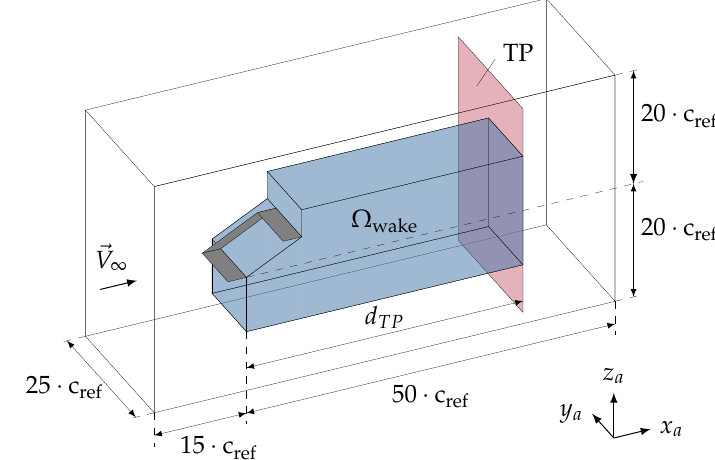
Figure 2. Schematic illustration of the flowfield, transverse plane (TP) and the correction volume Ω wake enclosing the wake region to compute the spurious entropy drag